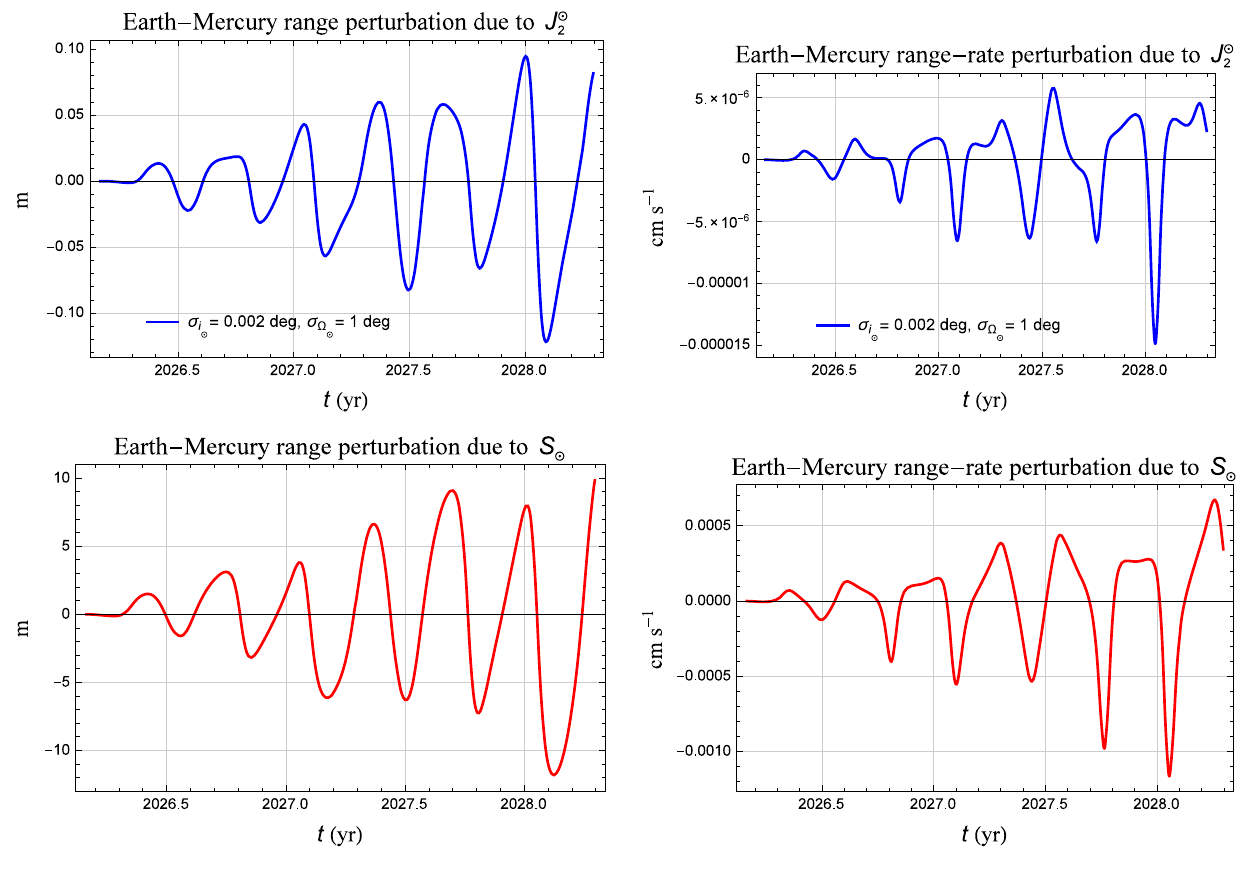
Fig. 3 Upper row (blue): mismodelled Earth–Mercury range (in m) to the Sun’s angular momentum S (cid:3) through the Lense–Thirring effect and range-rate (cm s − 1 ) J (cid:3) during the same temporal interval. A coordinate system with the mean -induced perturbations due to the uncer- 2 ecliptic at the epoch J2000.0 as fundamental reference { x , y } plane tainties σ (cid:6) (cid:3) , σ i (cid:3) in the Carrington elements (cid:6) (cid:3) , i (cid:3) of the Sun’s spin was assumed. The initial values of the Earth and Mercury osculating axis ˆ S (cid:3) as in Beck and Giles [2] during the expected extended mis- orbital elements were retrieved from the Web-Interface HORIZONS sion of BepiColombo from 2026 March 14 to 2028 May 1. Lower row maintained by the JPL, NASA. For the nominal values of the Sun’s (red): nominal Earth–Mercury range and range-rate perturbations due physical parameters used, see Table